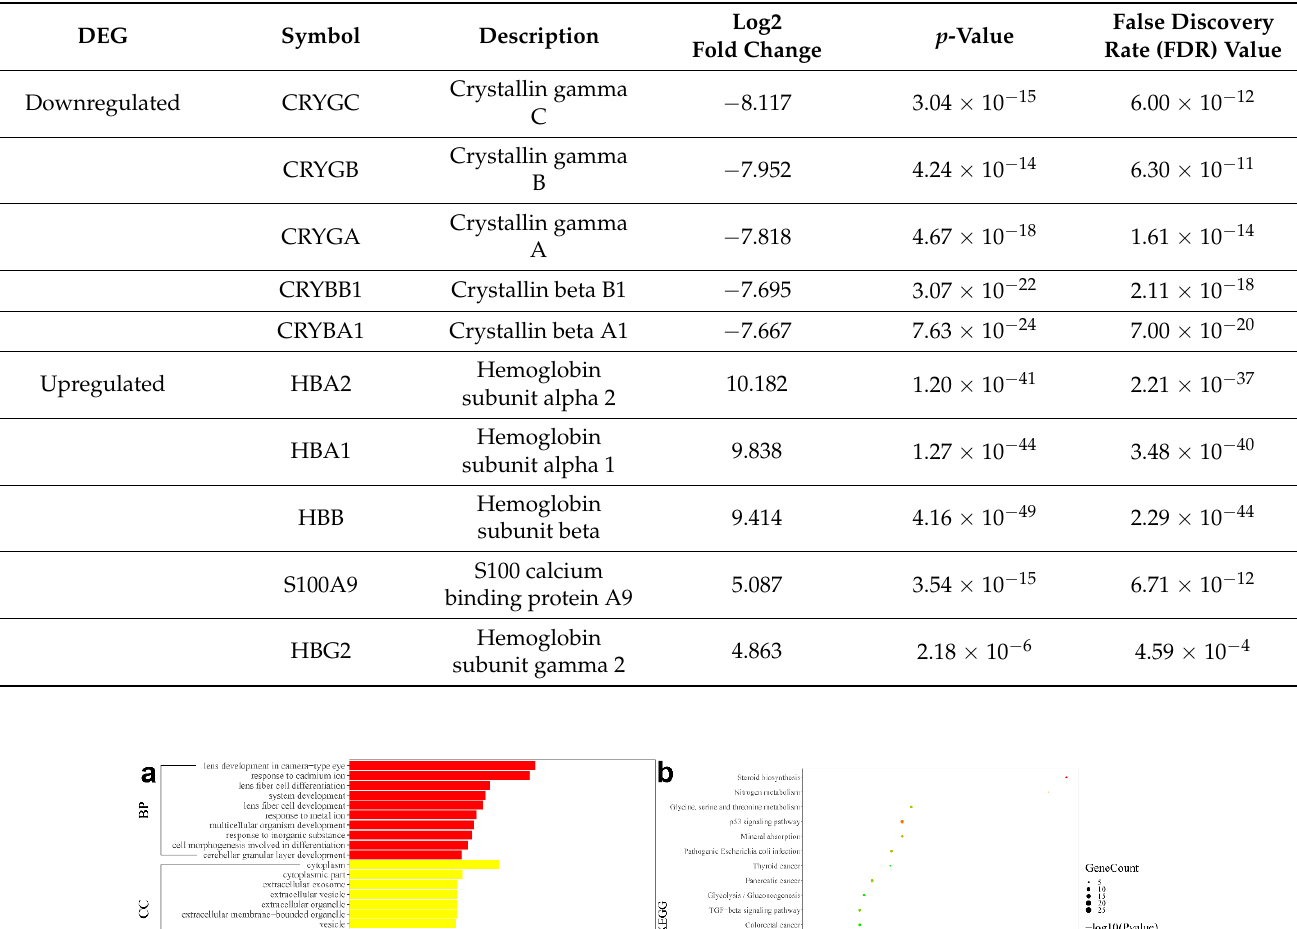
Table 3. The top 5 upregulated and downregulated DEGs in the anterior lens capsule samples of the posterior subcapsular congenital cataract patients.